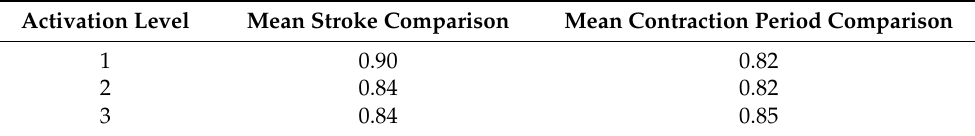
Table 6. Stroke and contraction period comparisons between the constant and minimum contraction period experiments, by activation level. All values expressed as